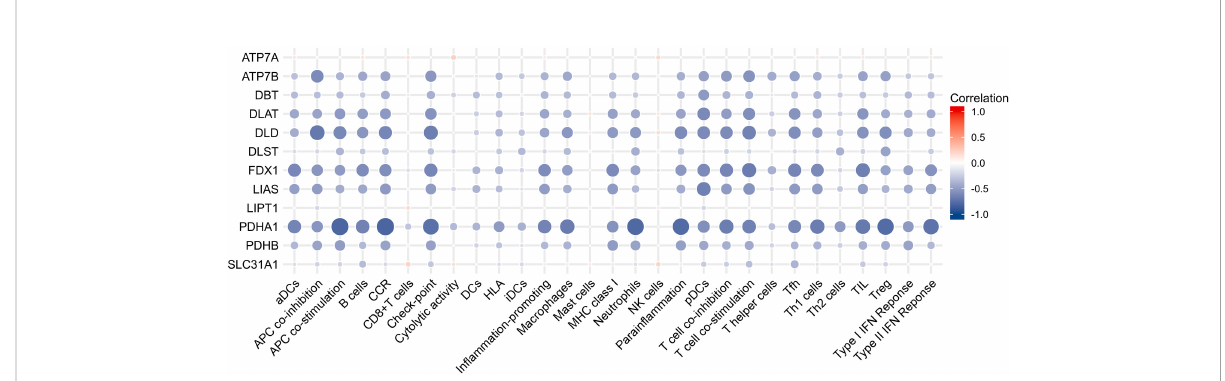
FIGURE 5 Correlation analysis between immune in fi ltration and cuproptosis-related genes.